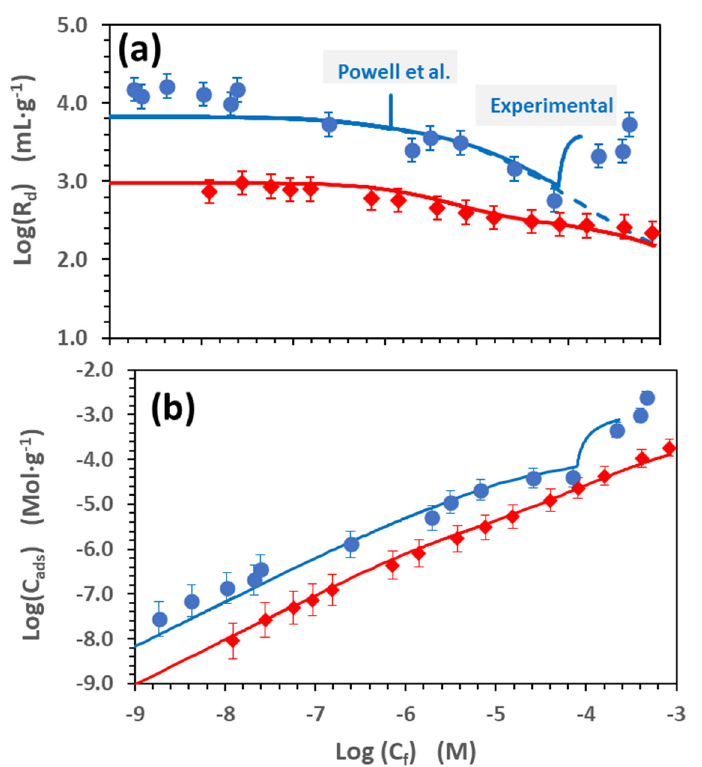
Figure 3. Cd adsorption edges in Na-smectite [0.57 − 0.86 g·L − 1 ]. ( a ) (  ) Comparison of sorption edges at two different Cd concentrations. [Cd] = 9.18·× 10 − 8 M and 0.1M NaClO 4 ; (  ) [Cd]= 1·× 10 − 5 M and 0.1M NaClO 4 ; (  ) [Cd] = 9.18·× 10 − 8 M and 0.01M NaClO 4 . ( b ) Comparison of sorption edges with different contents of chloride. (  ) Reference standard test (Cd] =1·10 − 5 M with HCl and CdCl 2 ); (  ) [Cd] =1·10 − 5 M with Cd(ClO 4 ) 2 and traces of 109 CdCl 2 (1·× 10 − 8 M); (  ) [Cd] =1·10 − 5 M without Cl (only HClO 4 and Cd(ClO 4 ) 2 . The line represents the model calculation with the parameters of Table